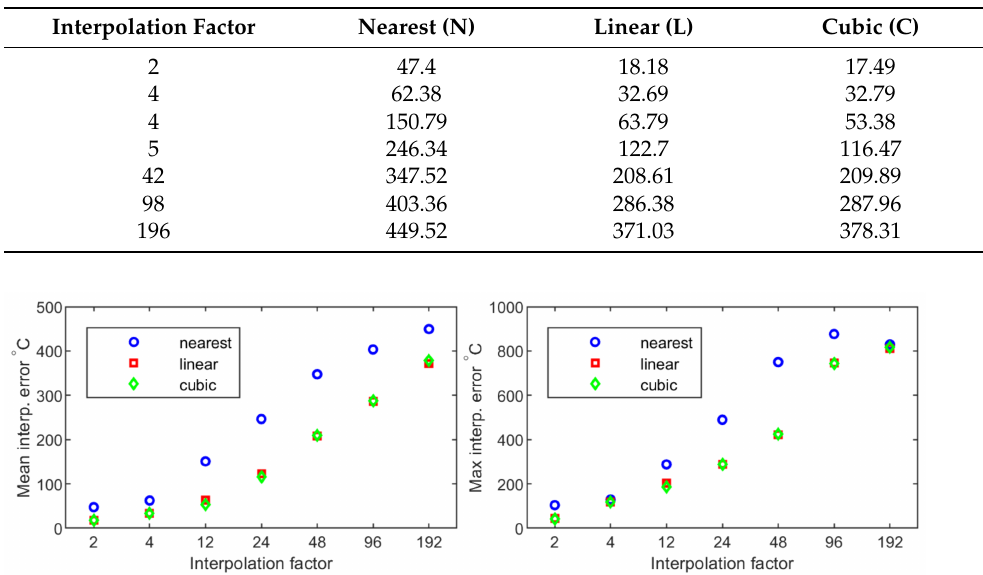
Table 4. Mean interpolation error between the original and interpolated IR sequences for all the